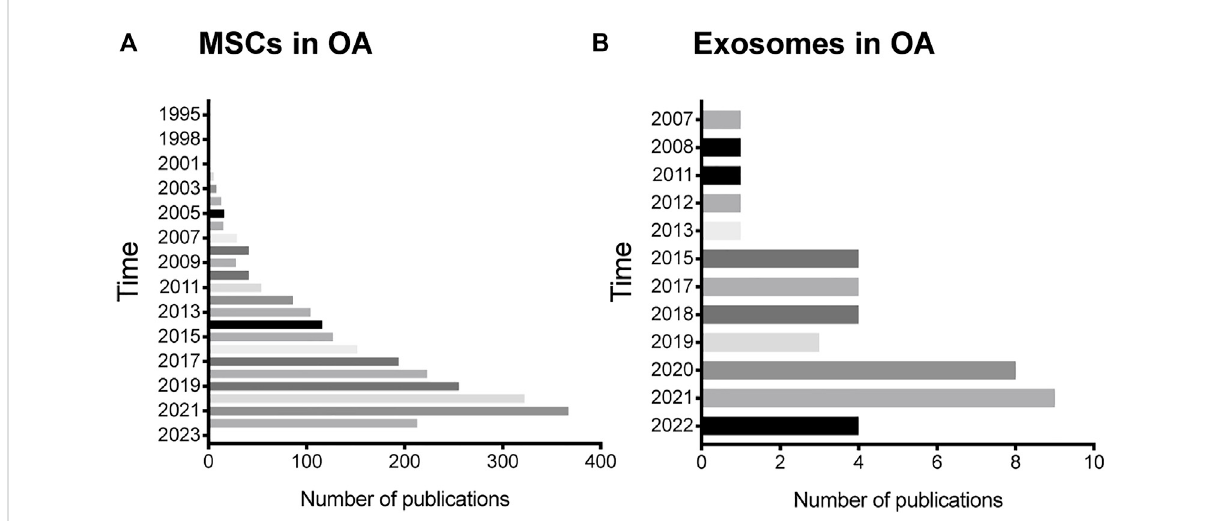
FIGURE 2 StatusofMSCsandexosomesresearchinOA. (A) TheannualnumberofpublicationsrelatedtoMSCsresearchinOAinthepast27 years. (B) The annual number of publications related to exosomes research in OA in the past 15